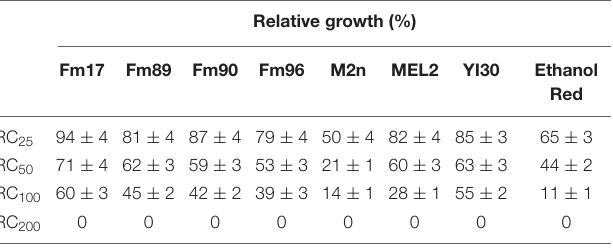
TABLE 4 | Influence of increasing concentrations of mixtures of weak acids (acetic and formic acid) and furans (furfural and HMF) on aerobic yeast growth in defined YNB medium supplemented with 20 g/L of glucose.